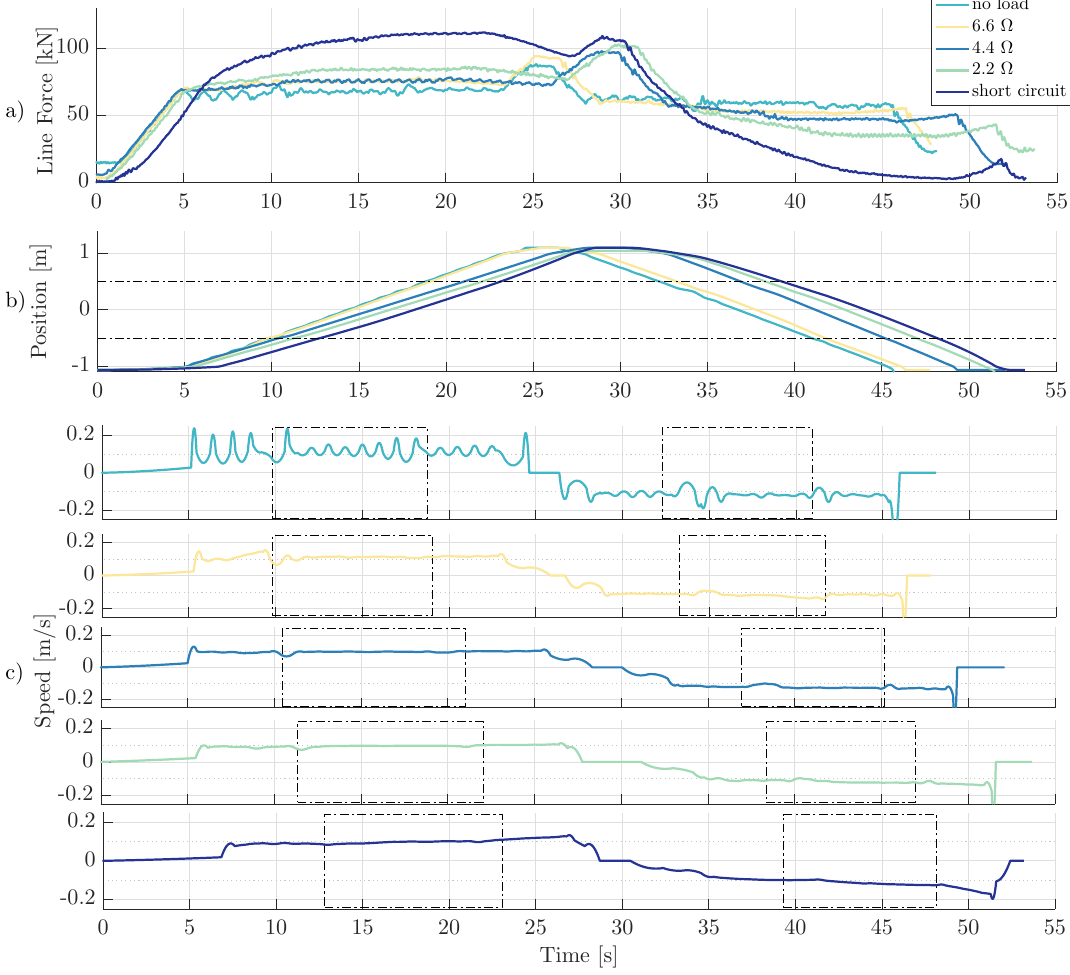
Figure 2. Measured line force ( a ), translator position ( b ) and translator speed ( c ) in time domain for the low speed tests. Dotted areas mark out full active